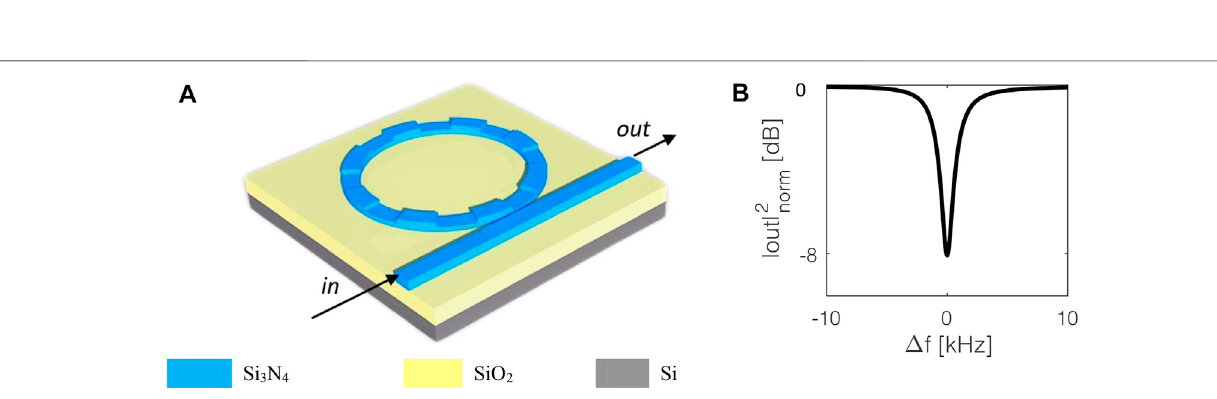
Frontiers in Physics |